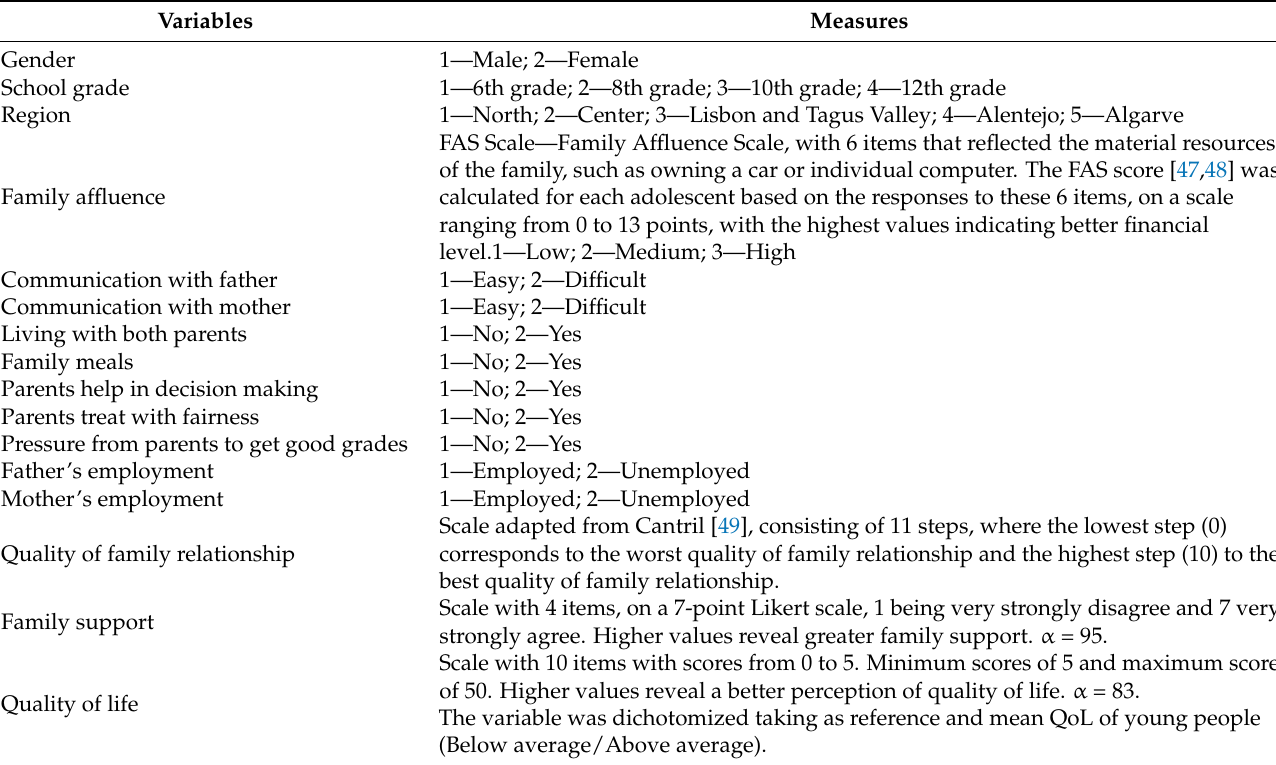
Table 1. Measures and variables under